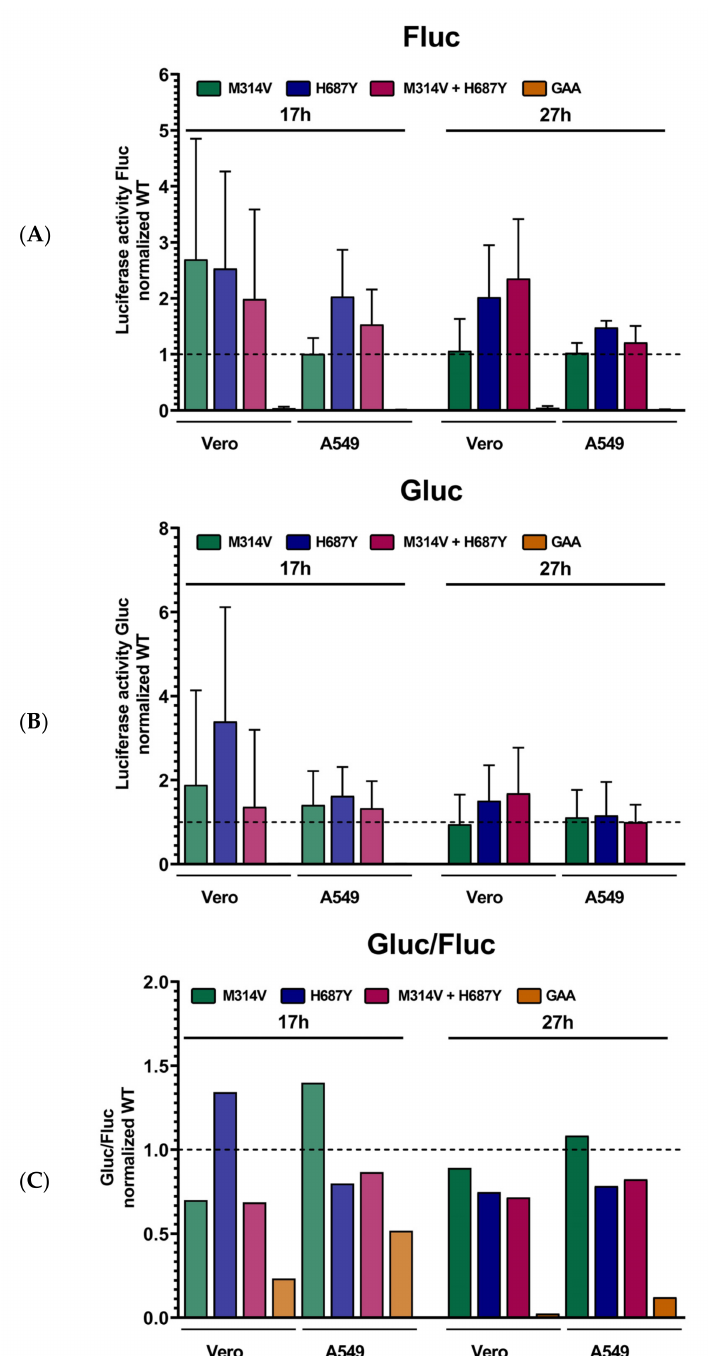
Figure 4. Trans-replicase assay to test role nsP mutations on viral replication complex efficiency. ( A ) Fluc activity, ( B ) Gluc activity and the ( C ) ratio Gluc/Fluc are shown. Activity was measured after 17 h and 27 h. nsP1 mutation M314V and nsP2 mutation H687Y were tested separately and combined. The nsP4 GAA catalytic mutant was used as a control as it abolishes viral polymerase activity. All data were normalized to a WT control, indicated by the dashed line, for each time point and cell line. At least two biological replicates ( n = 4) were performed. Mean ± SD is shown. 3.5. Adaptive Mutations in the Envelope E2 Protein Enhance Attachment to Both A549 and Vero